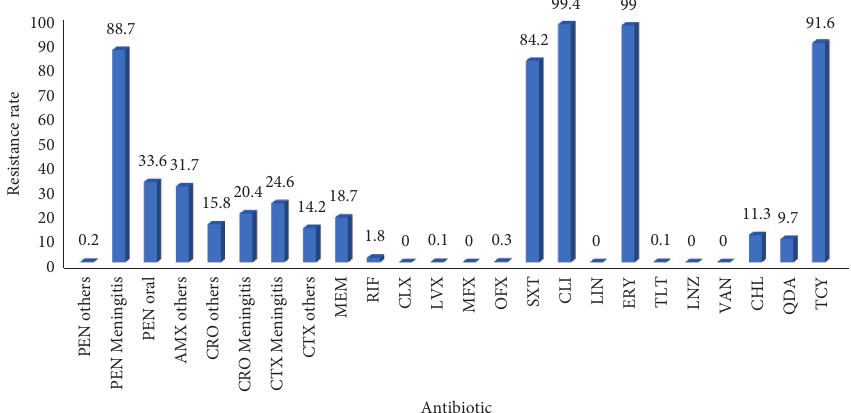
Figure 12: Distribution of drug resistance of S. pneumoniae from 2018 to 2020 (%).